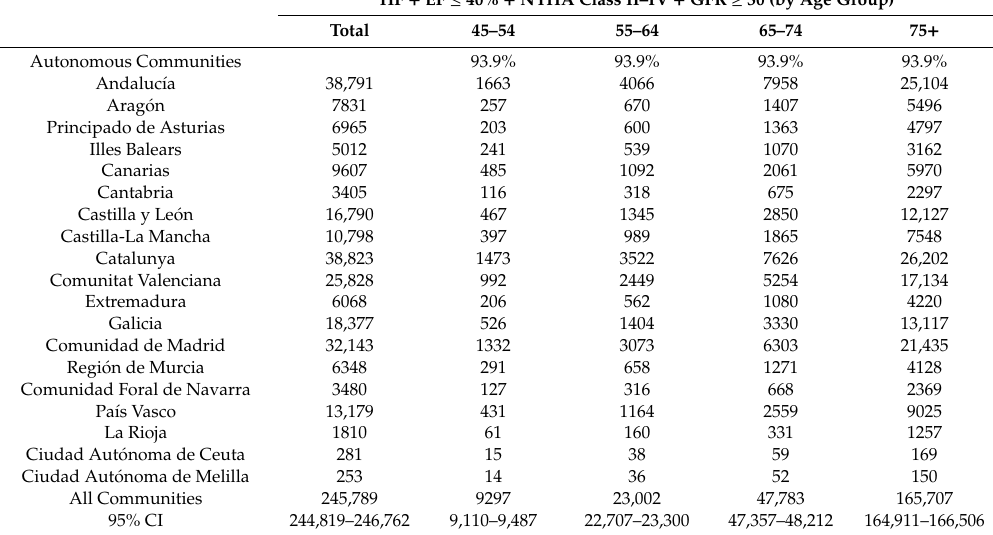
Table 6. Total number of patients with heart failure ejection fraction ≤ 40%, New York Heart Association functional class II–IV, and glomerular filtration rate ≥ 30 mL / min / 1.73 m 2 in Spain and its autonomous communities